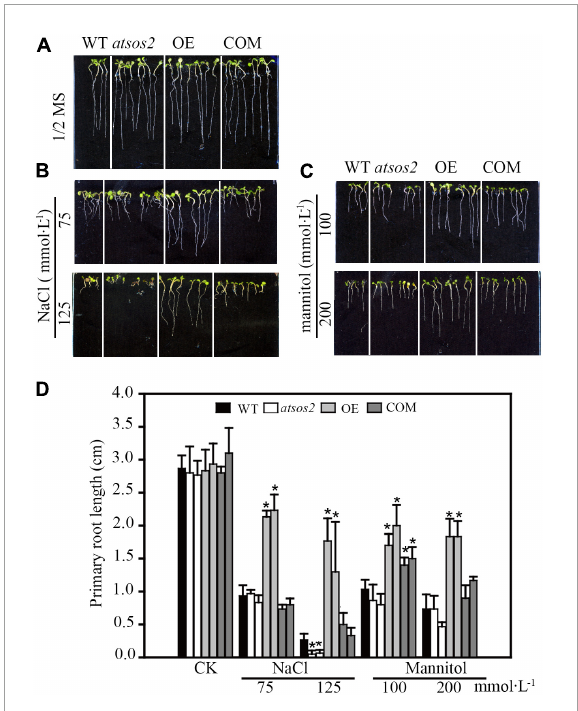
FIGURE7 Phenotype of WT, atsos2 , OE, and COM under salt and mannitol stress. (A) 1/2 MS. (B) 1/2 MS with 75, 125 mmol L − 1 NaCl. (C) 1/2 MS with 100 and 200 mmol L − 1 mannitol. (D) Primary root length. Data were collected from seeds grown on medium 10 days after planting. Mean ± SD, n ≥ 3, * p < 0.05 (Student’s t